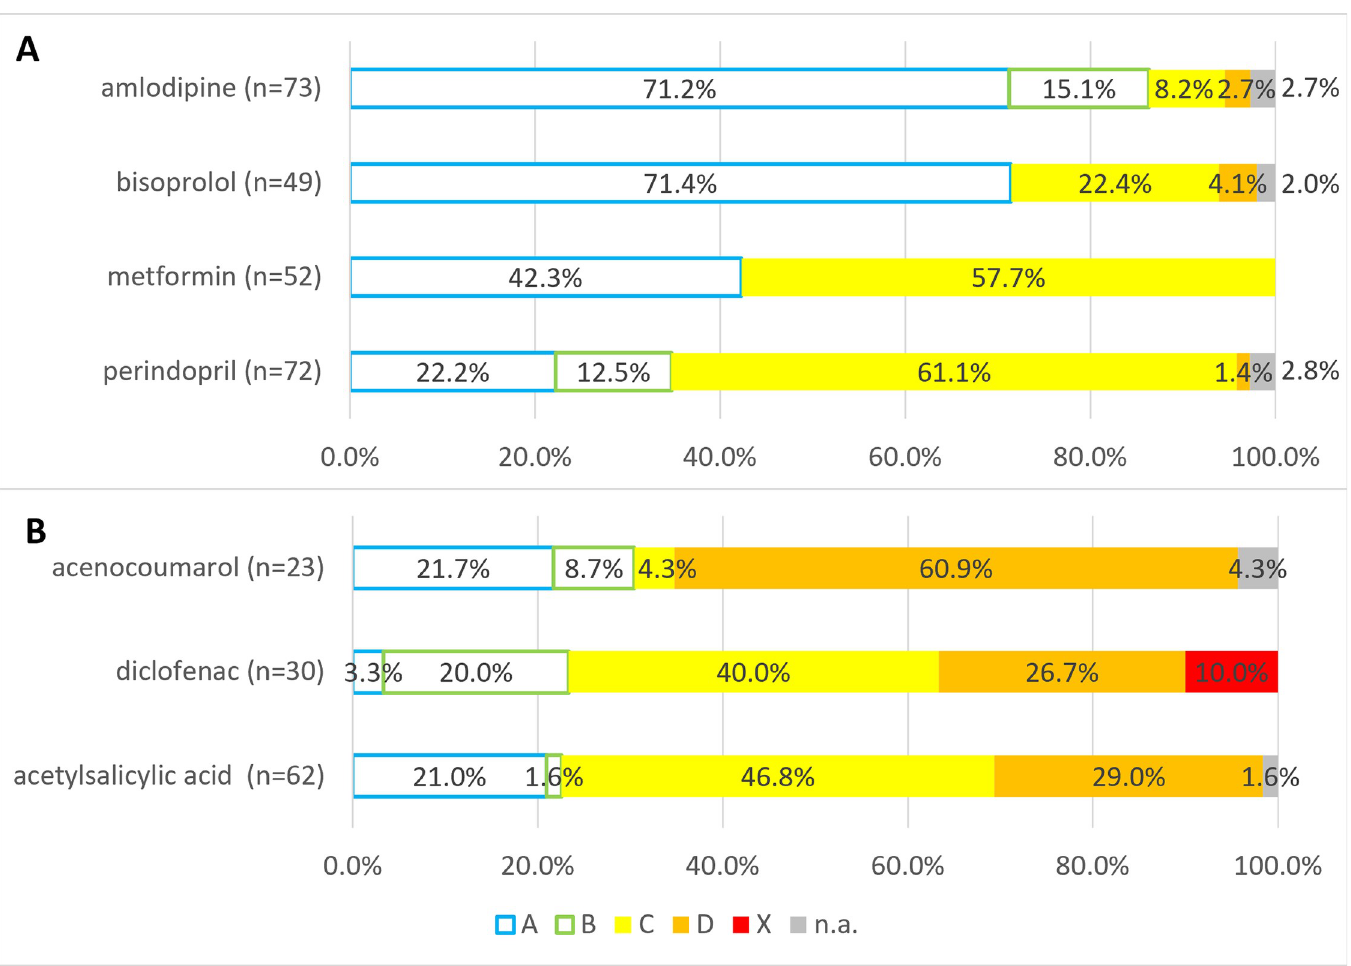
Fig 5. Distribution of interactions by clinical risk caused by active substances causing the most Grade A/B or Grade D/X interactions. 5/A: Distribution of interactions by clinical risk caused by active substances causing the most Grade A/B interactions. 5/B: Distribution of interactions by clinical risk caused by active substances causing the most Grade D/X interactions. A: No known interaction; B: No action needed; C: Monitor therapy; D: Consider therapy modification; X: Avoid combination; n.a.: Not available. https://doi.org/10.1371/journal.pone.0253645.g005 Table 6. Grade D or X interaction pairs of the three most common D or X interacting agents (acenocoumarol, acetylsalicylic acid, and diclofenac). Active substances causing Grade D or X interaction with